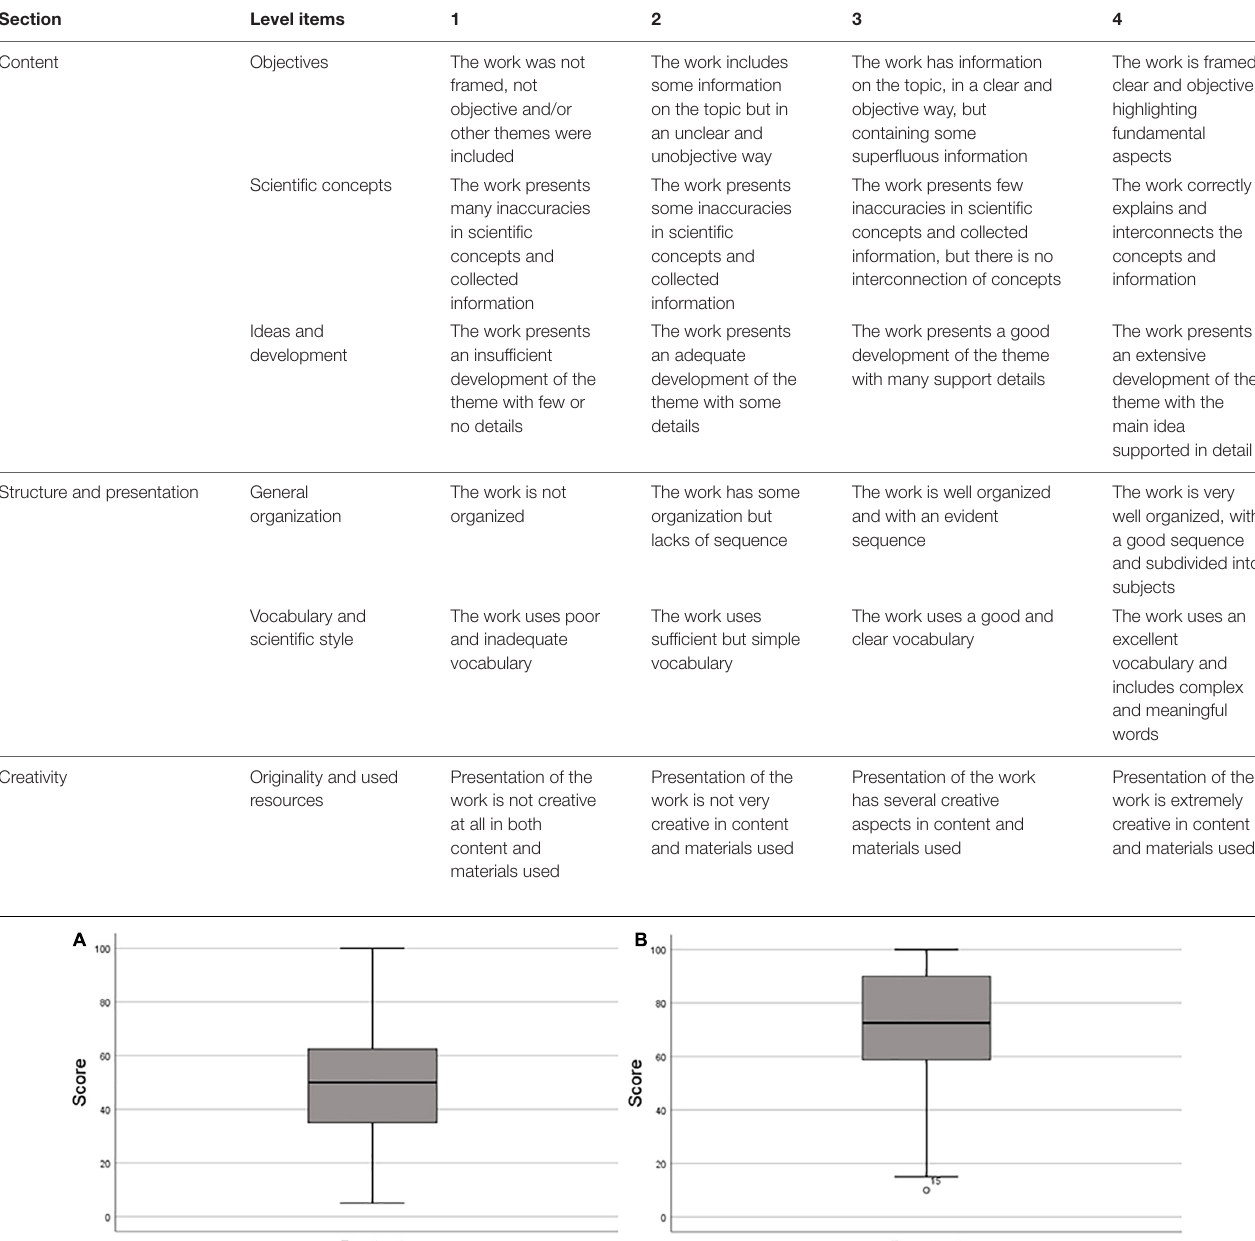
TABLE 1 | Rubric for content analysis of the final works produced by the students. Section